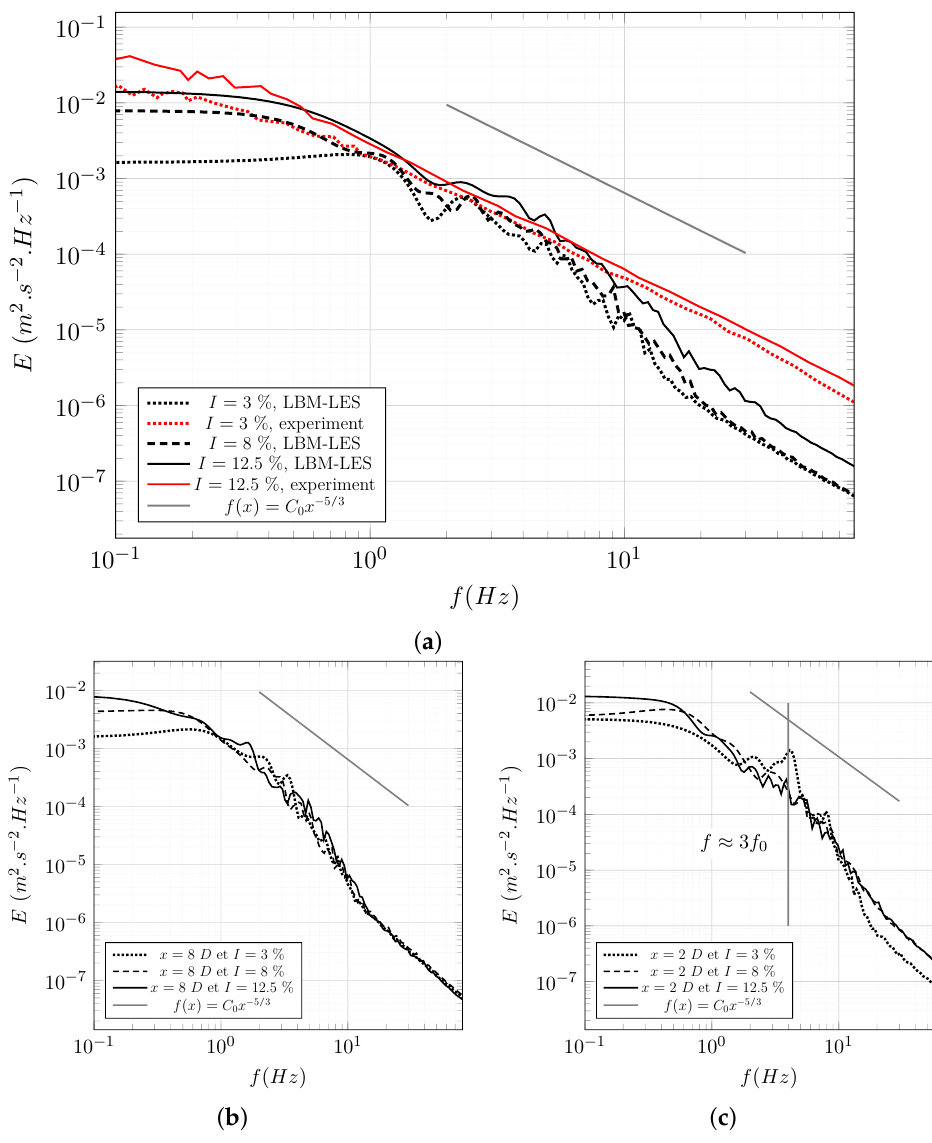
Figure 26. LBM-LES simulation of the tidal turbine at TSR = 3.67. PSD calculated from the axial velocity U x for I = [ 3,8,12.5 ] %. Experimental data are from [38] at TSR = 4.0. ( a ) x = 4.0 D , y = z = 0 m. ( b ) x = 8.0 D , y = z = 0 m. ( c ) x = 2 D , y = R and z = 0